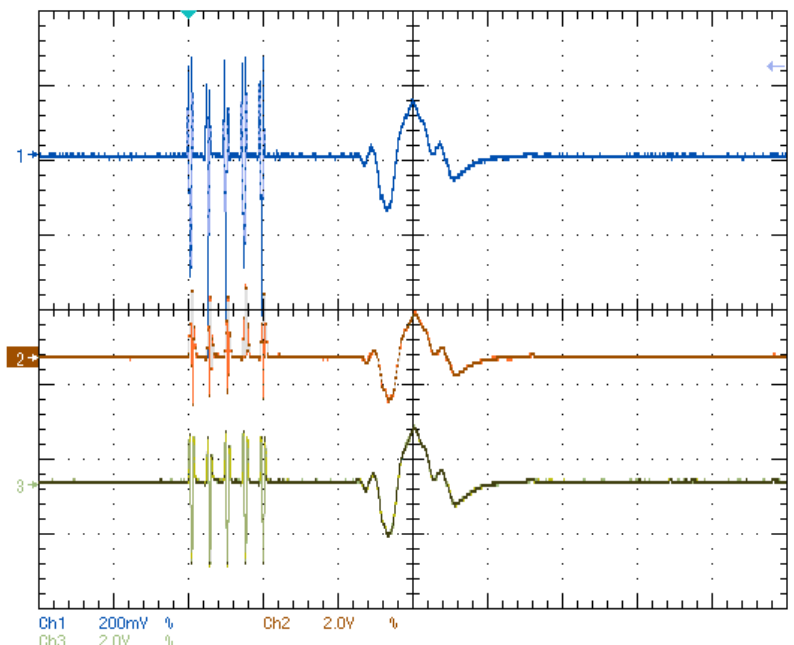
Figure 10. Blue curve: Transmitter input signal; purple curve: Receiver embedded DAC output signal; Olive green track: Receiver analog output signal. Horizontal scale is 10ms/div.